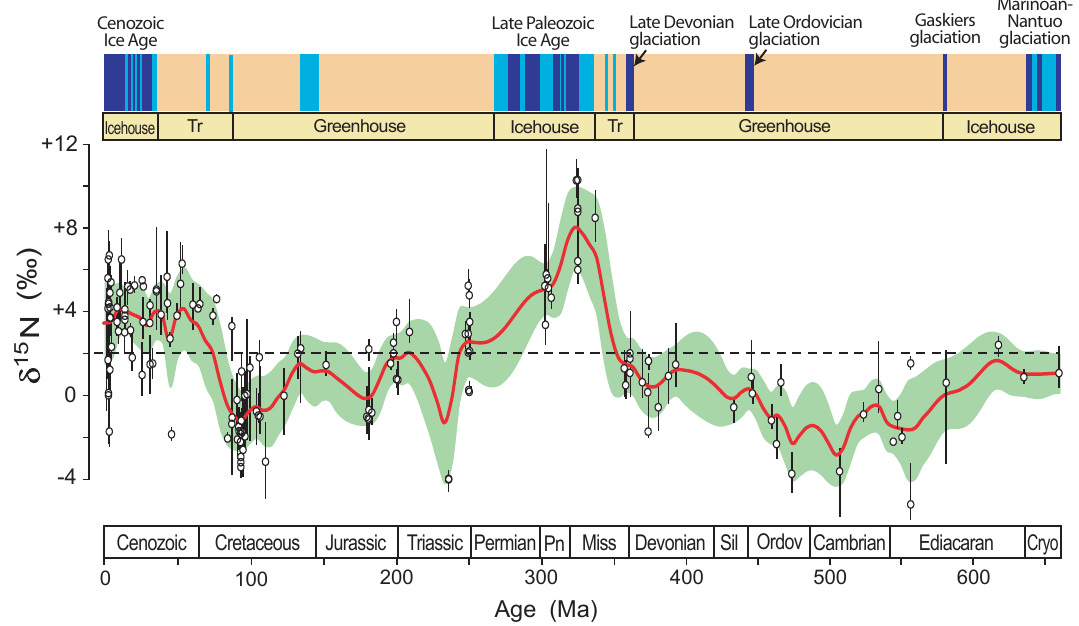
Figure 1 Fig. 1. Long-term secular variation in marine sediment δ 15 N, based on 153 study units of Neoproterozoic and Phanerozoic age. This data set yields a mean δ 15 N sed of + 2.0 ± 0.3‰ (mean ± 1 standard error of the mean; dashed line). For each unit, the distribution of δ 15 N values is represented by the median (open circle) and the 16th-to-84th percentile range (vertical line) (see Table 1). The mean long-term trend is given by a LOWESS curve (red line) and uncertainty envelope ( ± 1 σ ; green field). The LOWESS curve, which varies overa ∼ 10‰ range, accounts for 74% of total variance in the δ 15 N sed data set. At top, epochs of moderate (light blue) and heavy (dark blue) continental glaciation are from Montañez et al. (2011); the ages of all marine sedimentary units and climate events have been adjusted to the timescale of Gradstein et al. (2012). Tr = transitional